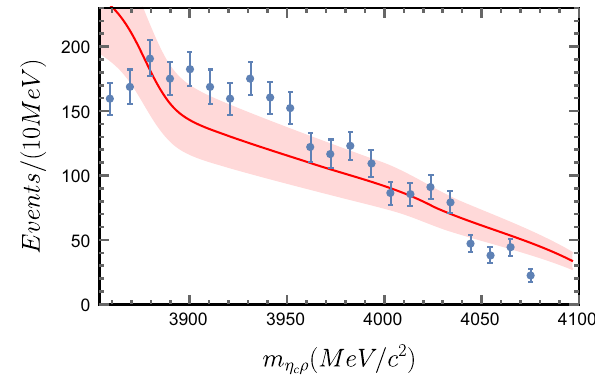
√ Fig. 4 Line shapes for η c ρ channel at s = 4 . 26 GeV (red line). Experimental data, shown as blue dots, is taken from Ref. [71]. The theoretical line shape has been convoluted with the experimental reso- lution. The shadowed area shows the 68% uncertainty of the line shape